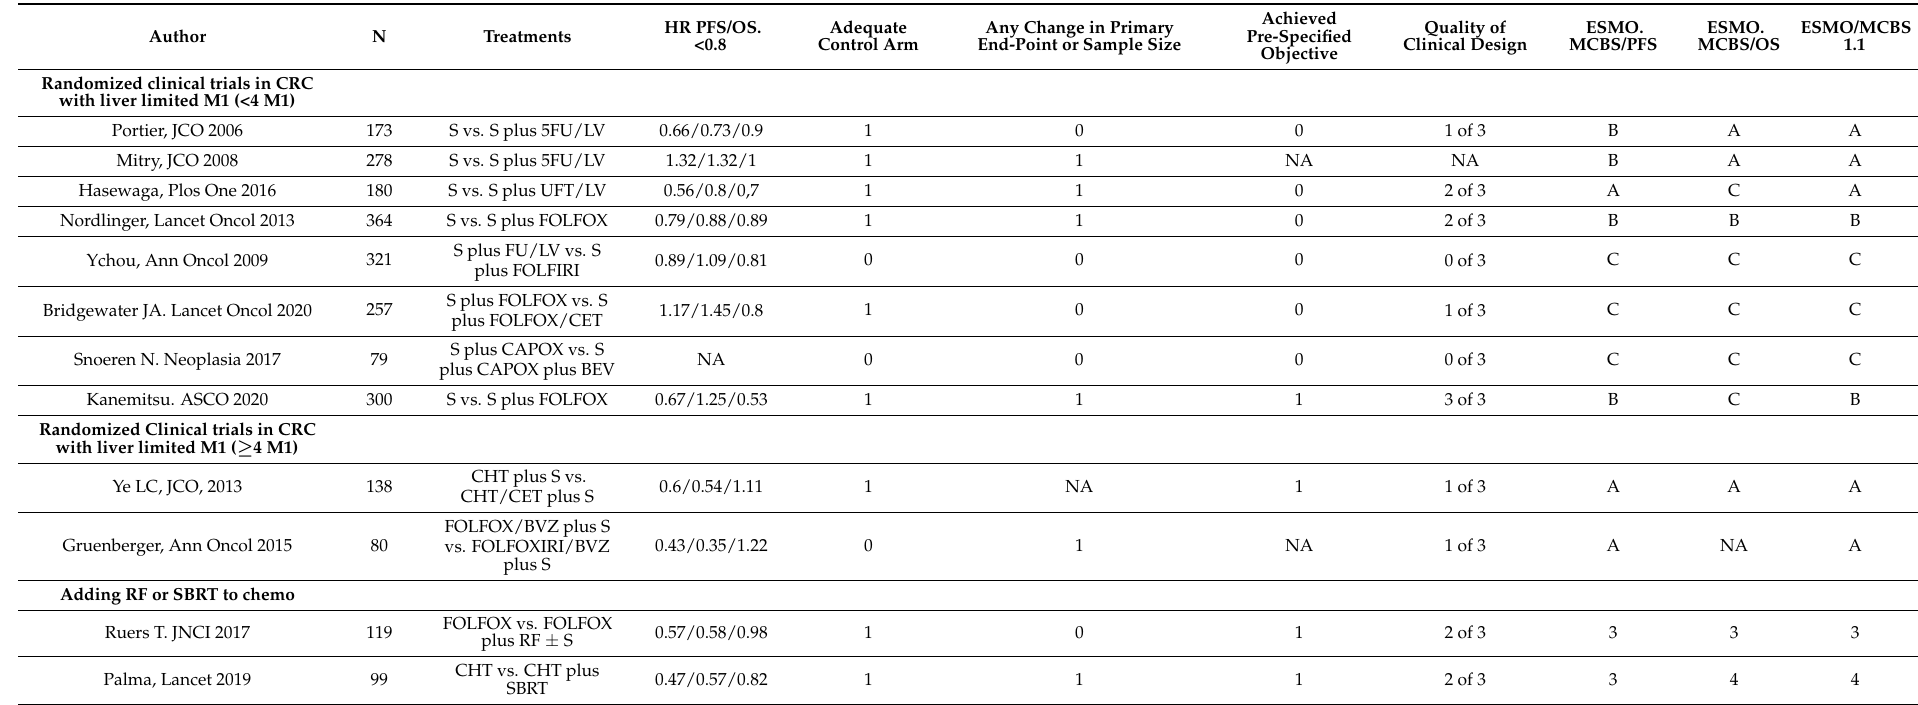
Table 1. ESMO-Magnitude of Clinical Benefit Scale (ESMO-MCBS) of studies with liver limited colorectal cancer